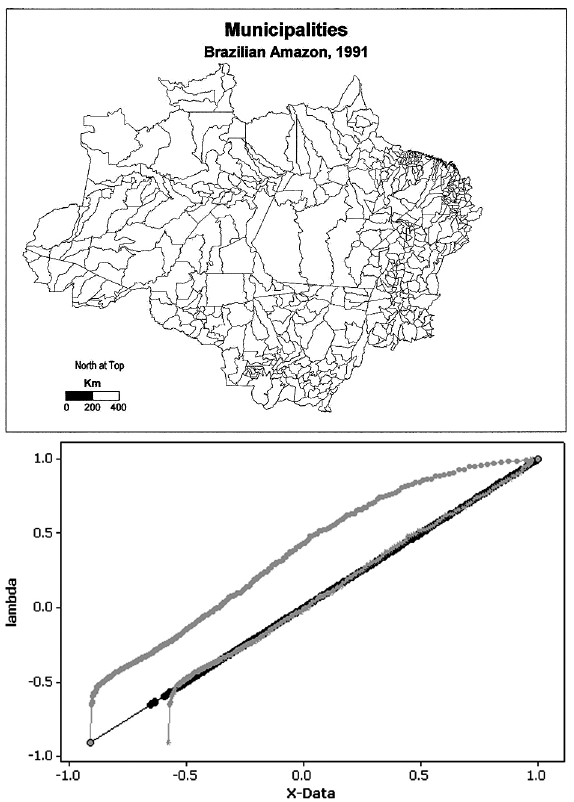
Fig. 1. Results for Amazon Brazil Top (a): the surface partitioning by municipalities. Bottom (b): eigenvalues (vertical axis: observed; horizontal axis: predicted) for the adjacency graph representation of Amazonian Brazil’s surface partitioning; o denotes the observed eigenvalues, * denotes predict - ed values from equation (1), and • denotes predicted values from equation